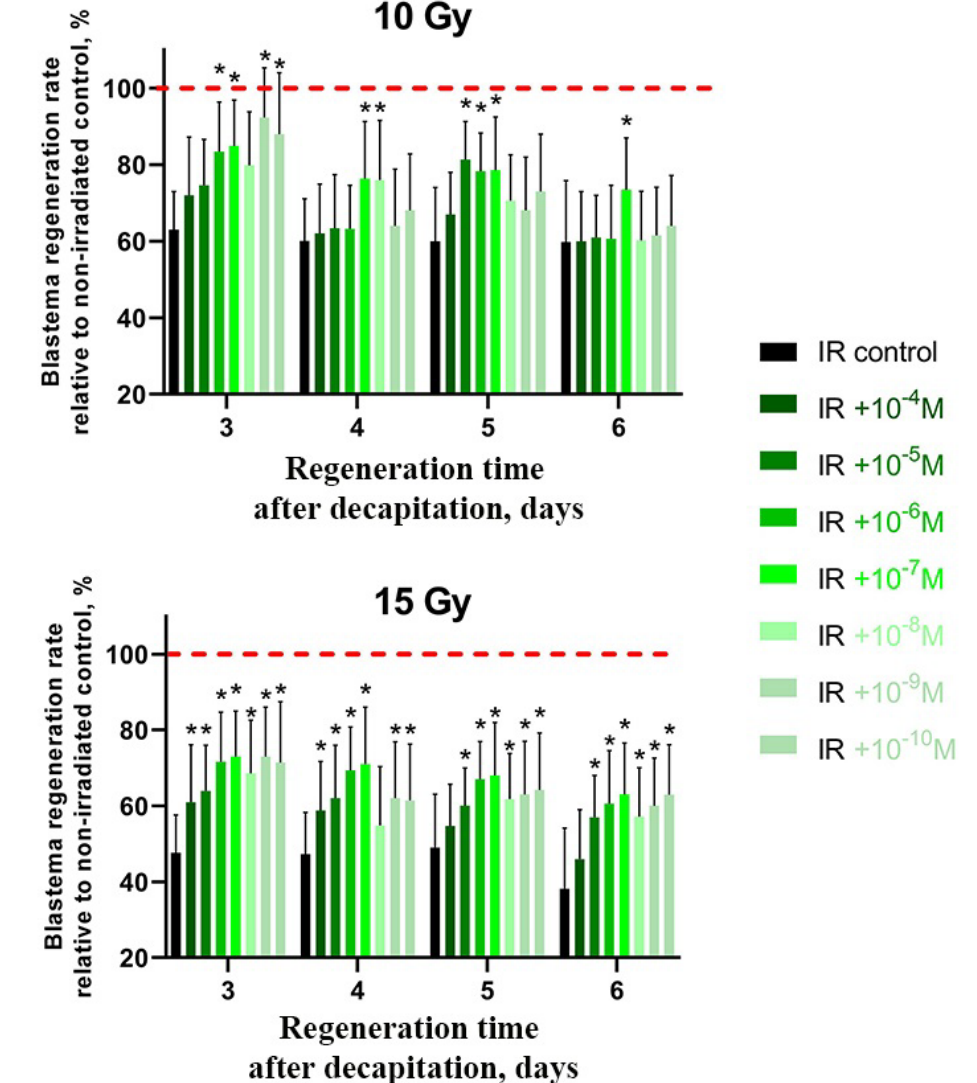
Figure 4. Radioprotective effect of CeF 3 nanoparticles on regenerating planarian blastema after irradiation with 10 Gy and 15 Gy. Green to light-green bars represent the percentage of blastema regeneration rate; the regeneration rate of non-irradiated animals was taken as 100% (red line). * p < 0.05 (difference from the control group). M ± SD, n = 90. IR — X-ray irradiation.